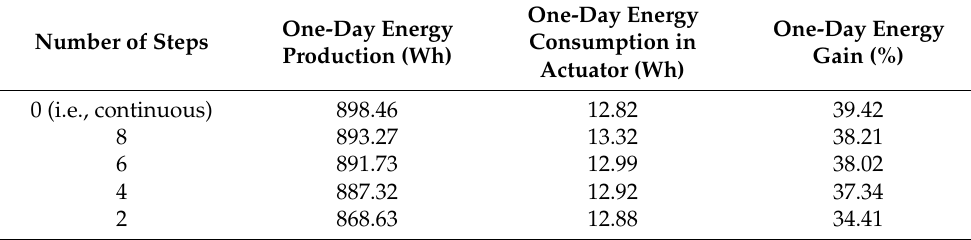
Table 1. Energy consumption in continuous and step-by-step tracking